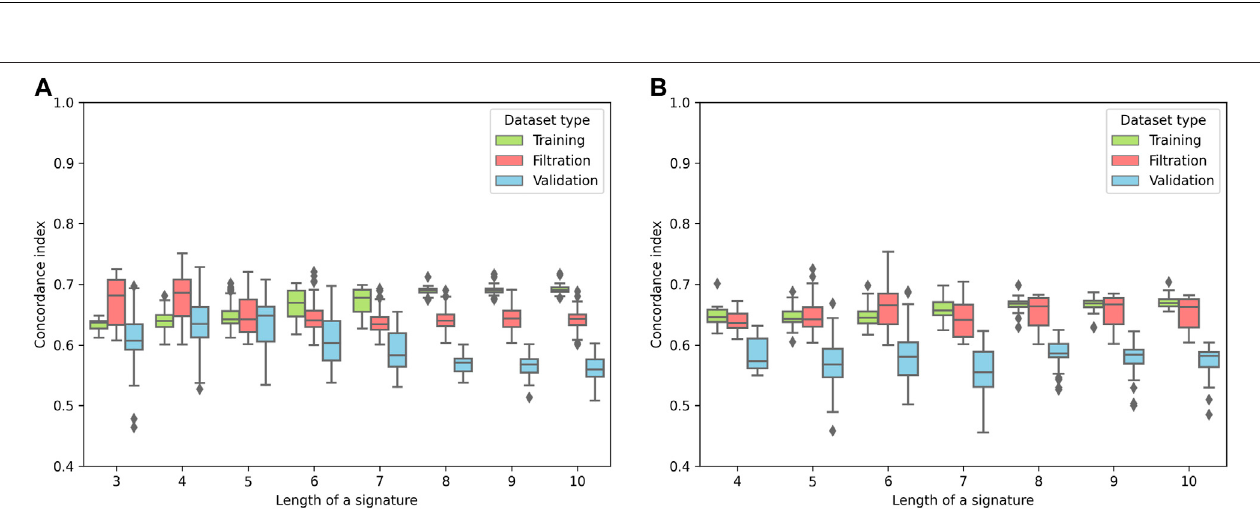
FIGURE 2 | Distribution of the concordance indices of the reliable models for different lengths of signatures. (A) ECM+ models. (B) ECM models.